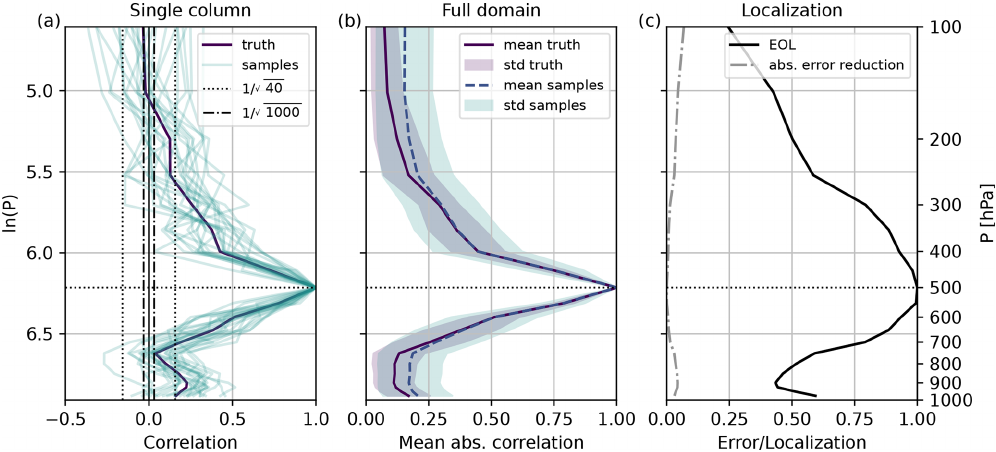
Figure 1. Vertical temperature–temperature correlations and empirical optimal localization for reference level 500hPa on 29 May 2016, 15:00UTC. (a) Single random column. (b) Domain average. (c) Estimated domain-uniform EOL and absolute error reduction. The sample includes the correlations from all 25 40-member subsamples. Shading indicates spatial